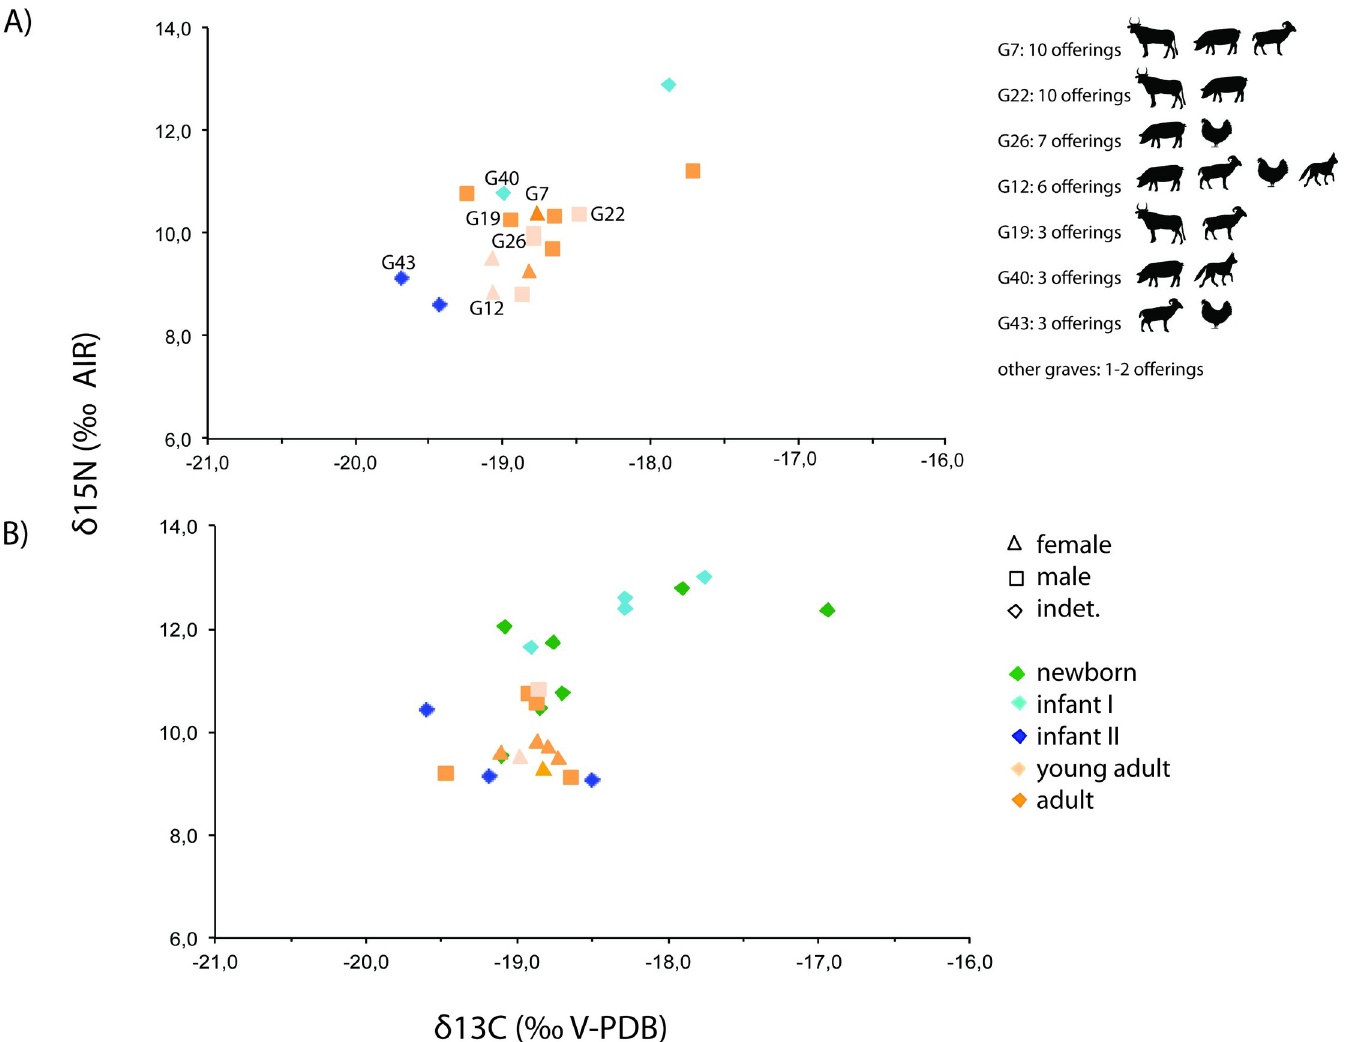
Fig 7. Plot of human bone collagen δ 13 C and δ 15 N values from Vila de Madrid according to the (A) presence and (B) absence of meat offerings and their number, and sex and age of the